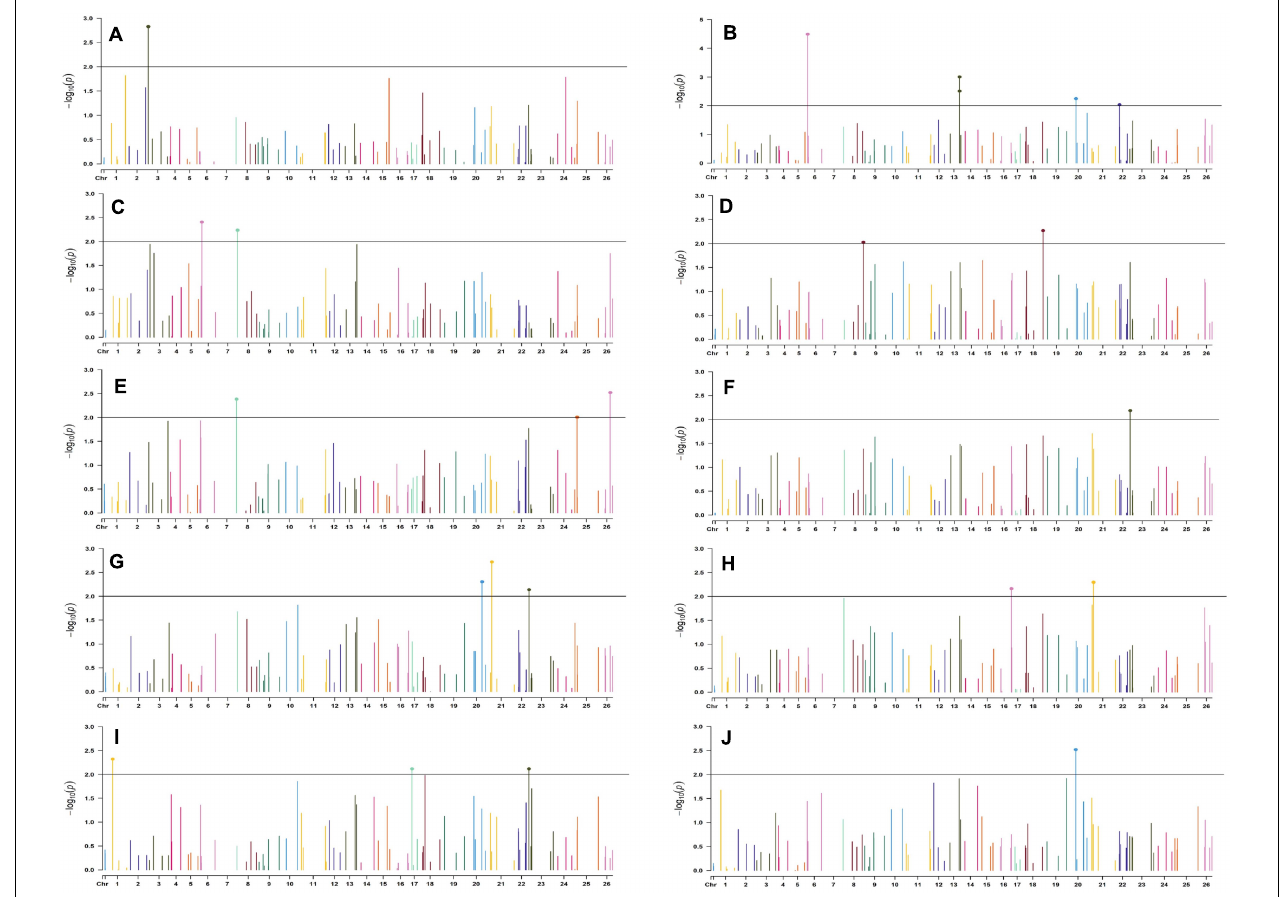
FIGURE 8 | Manhattan plots for the normal sown environment of 2019 for various traits under study by the MLMM model. Significant marker above threshold {at –log10 ( p ) > 2} is highlighted with bold dot head on the marker’s line. (A) Days to first flower, (B) plant height, (C) number of monopods, (D) number of bolls